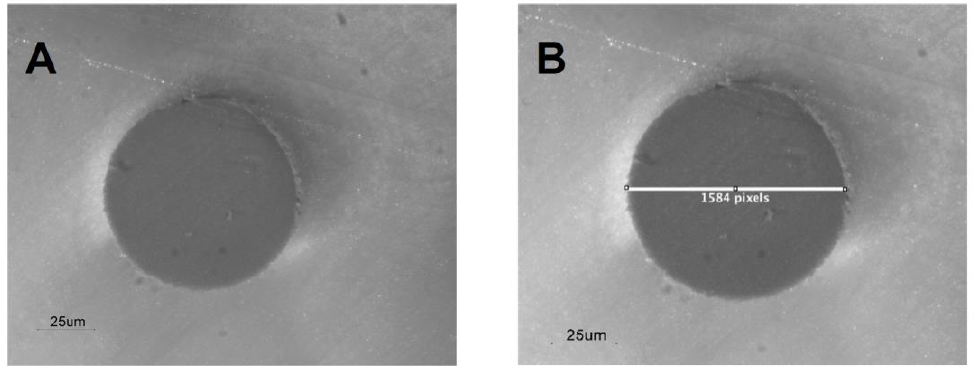
Figure 1. Image of root canal section, which shows the interface between dentin/sealer and sealer/gutta-percha ( A ) and the diameter measurement ( B